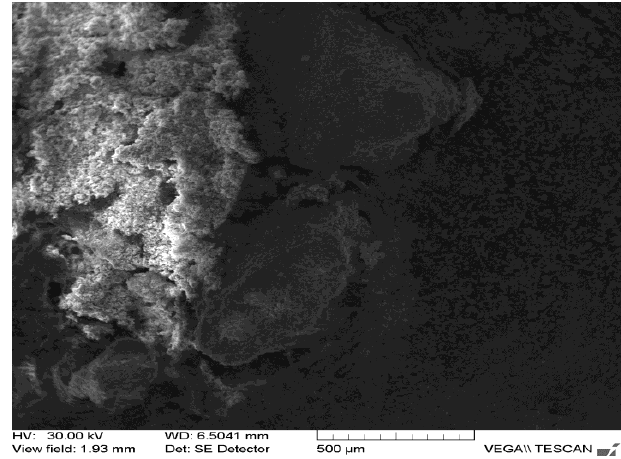
Figure 5. Detail of the previous image (Figure 4) that highlights the area adjacent to the excess bone deposition, with gaps in which osteoclasts (MTA) are present.